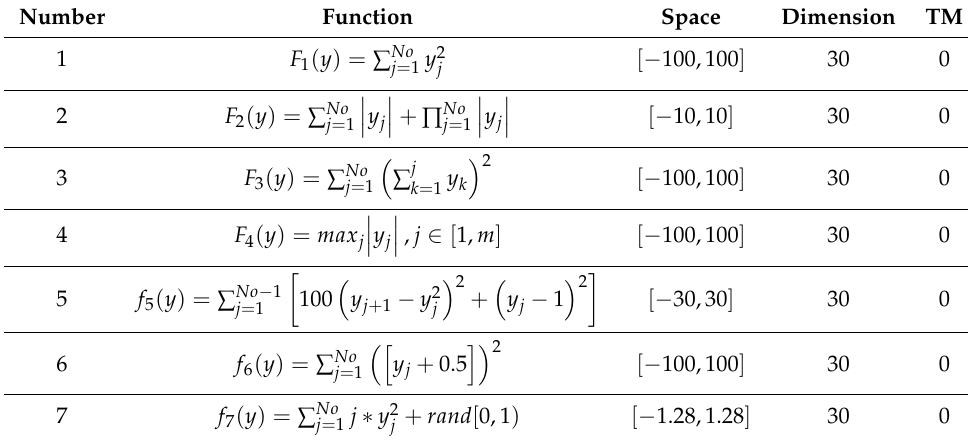
Table 1. Single peak in test function.